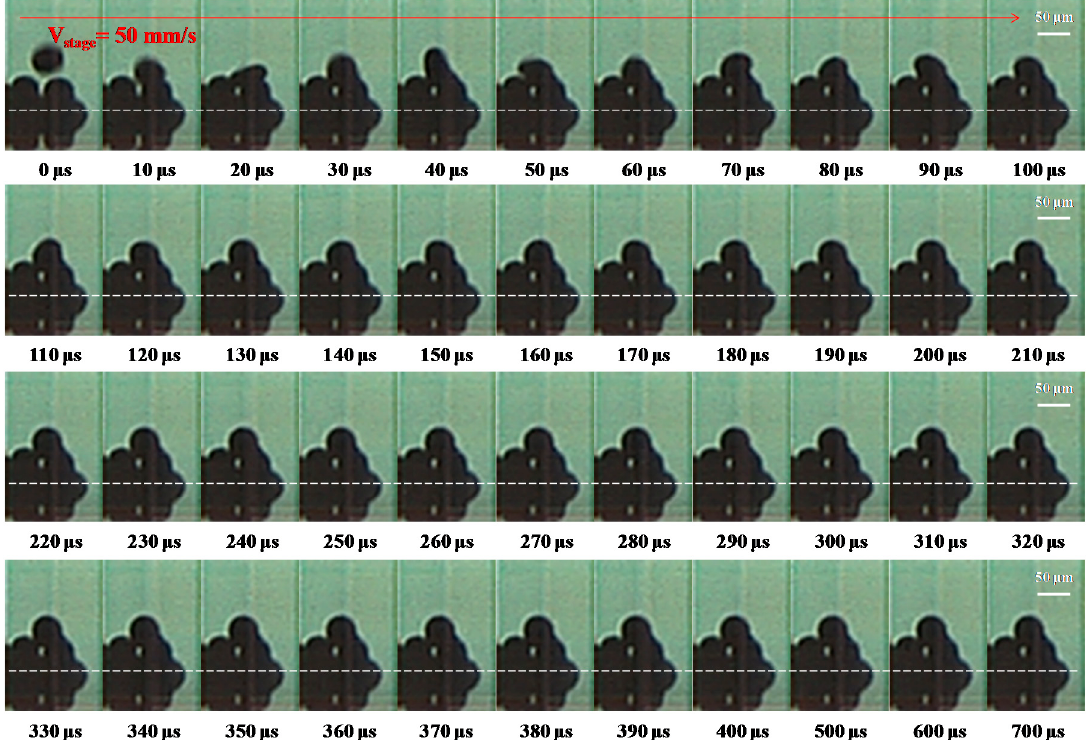
Figure 10. Evolution of the incoming droplet under a dot spacing of 50 μ m impacting onto a solidified droplet recorded using a high-speed digital camera with condition E in Table 2. The dashed lines separate the outline of the droplet from that of its reflection on the substrate at 50 °C (Ste = 0.645). The scale bars are 50 μ m.